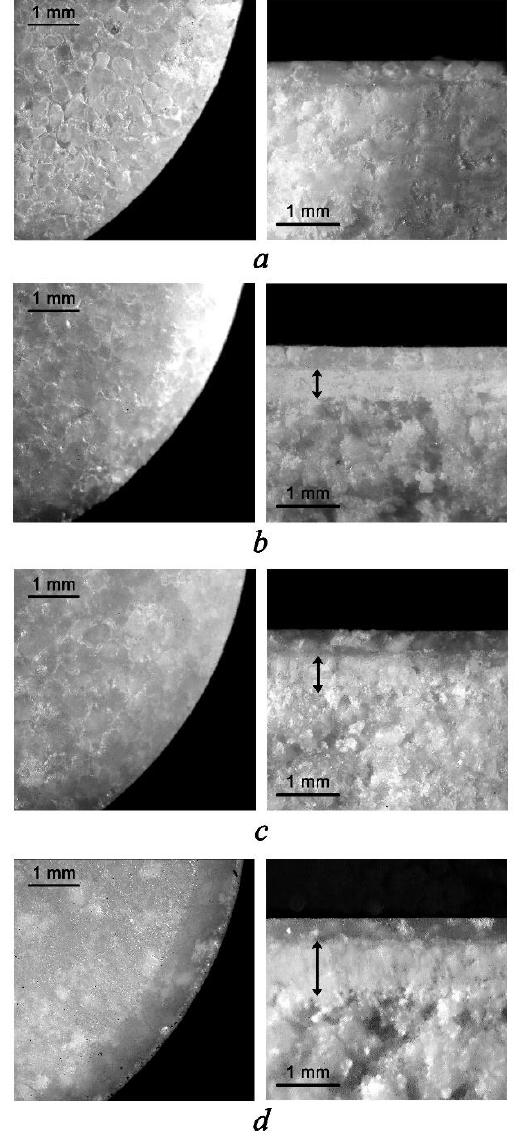
Figure 1. Digital microscopic images (20-fold magnification) of the surface and vertical cross-section of MCG batches compressed at different compression force values: ( a ) 5 kN; ( b ) 7 kN; ( c ) 10 kN; ( d ) 15 kN.